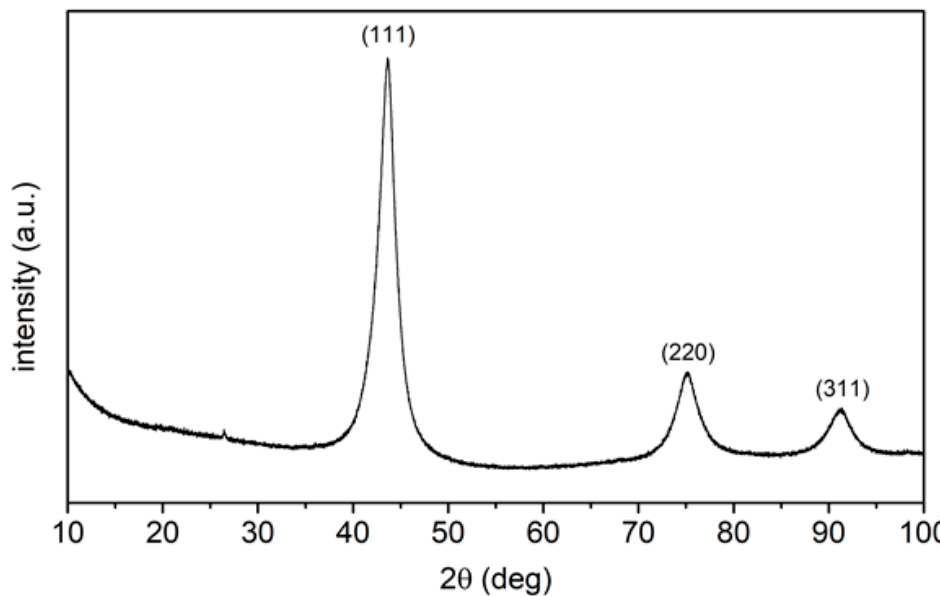
Figure 5. X-ray diffraction of a detonation nanodiamond particles (DND). In order to study the surface morphology of examined carbon nanomaterials in more detail, confocal microscopy studies were performed (Figure 6).